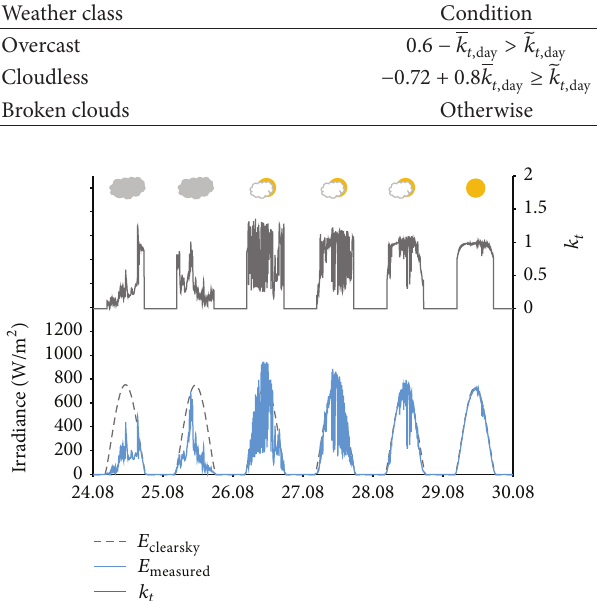
Figure 3: Example results of the weather category detection algo- rithm based on 𝑘 𝑡 patterns for 6 subsequent days from 24.08.2005 to 30.08.2005 in Lindenberg. Clear sky irradiance (dotted grey) and the clearness index (grey line on top) in comparison to the measured global irradiance (blue line, bottom). Visualization is done with one- minute values whereas the detection is based on hourly averaged values.